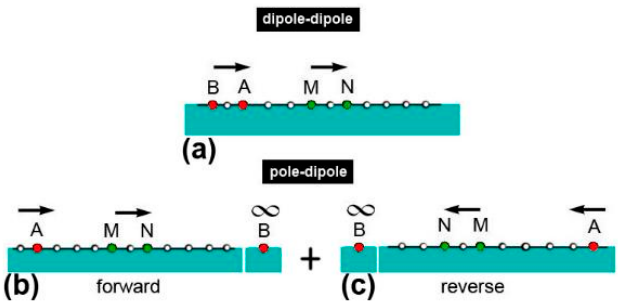
Figure 6. Configurations used for data collection: ( a ) Dipole–dipole and ( b , c ) Pole–dipole (forward + reverse).